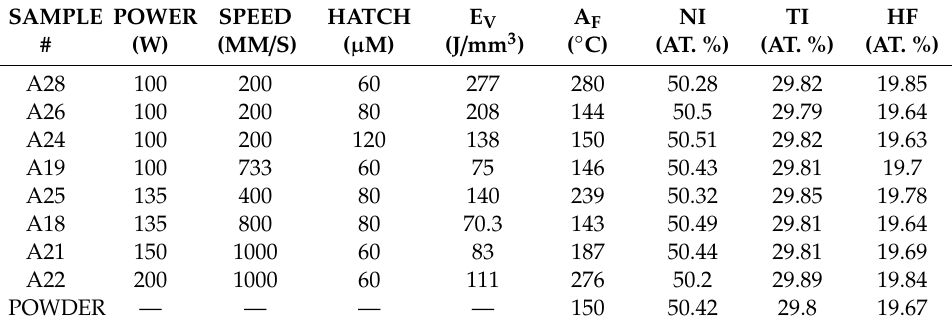
Table A1. Measured Nickel, Titanium, and Hafnium content for selected